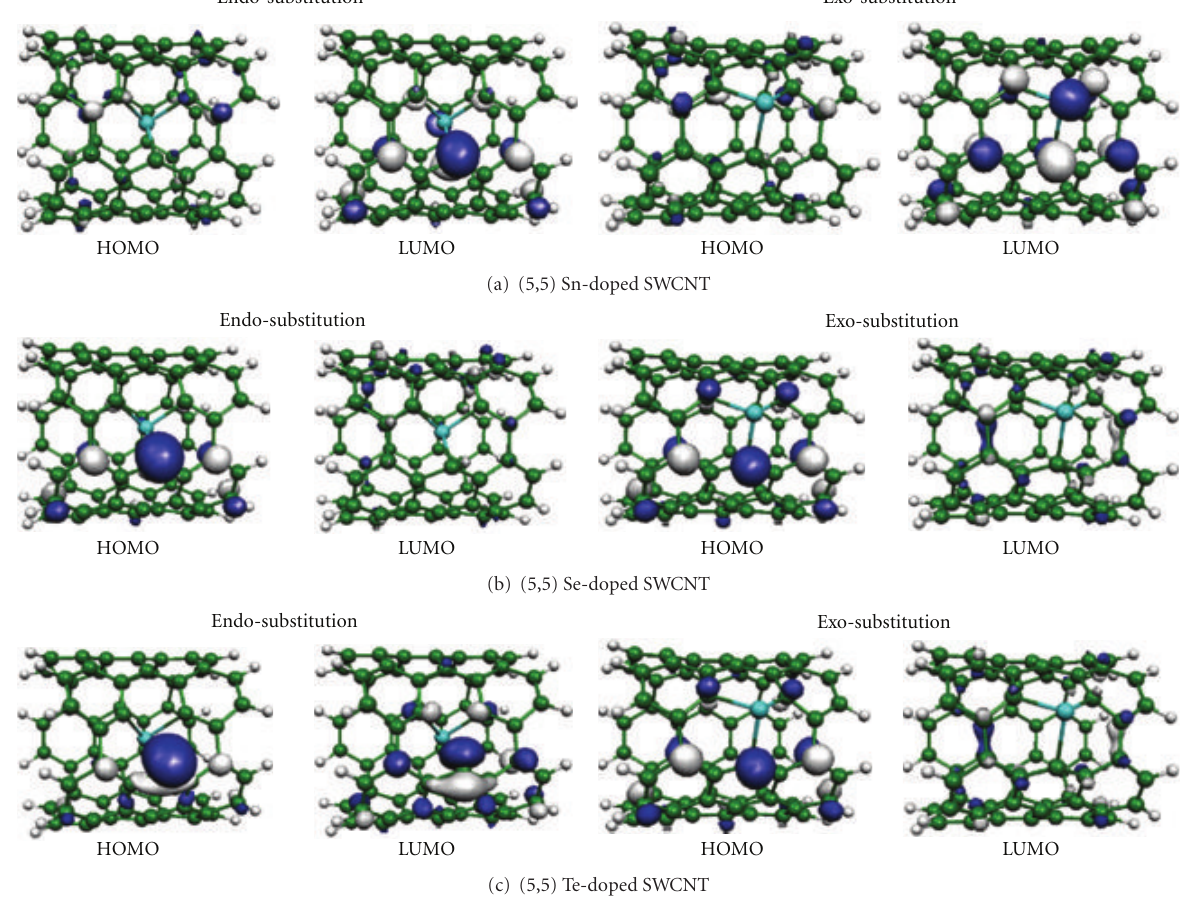
Figure 11: FMOs of Sn-, Se-, and Te-doped SWCNTs